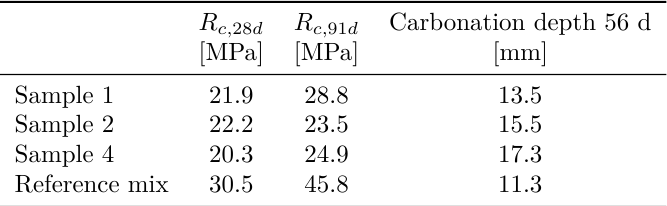
Table 3. Compressive strength and carbonation resistance of the concrete mixtures with treated